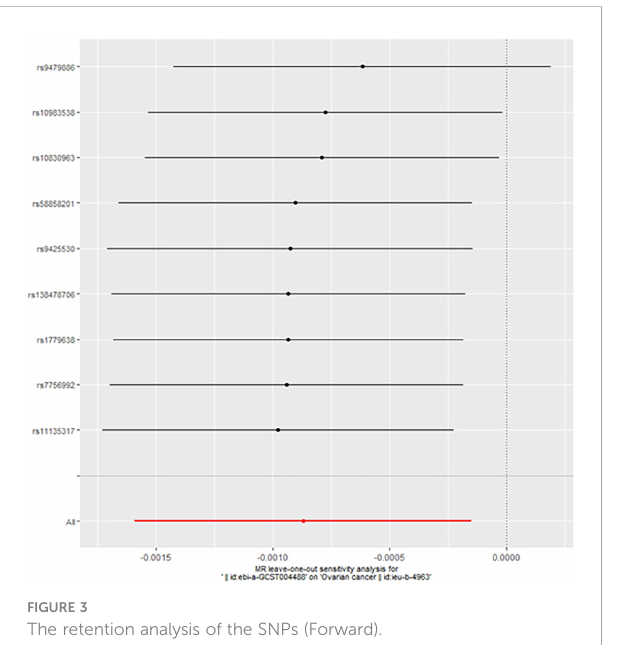
FIGURE 5 The pleiotropy test of MR analysis (Reverse).